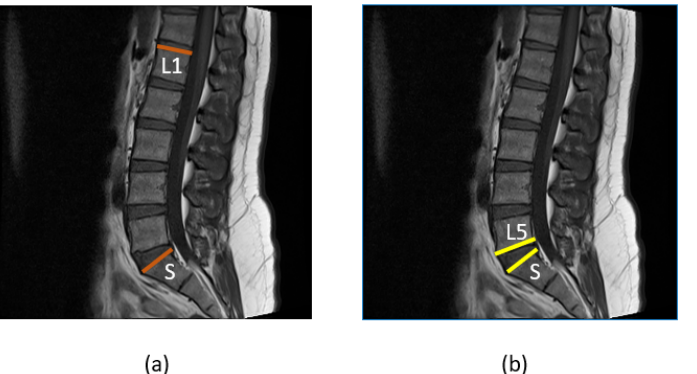
Figure 8. ( a ) Brown lines are drawn on the superior endplates of L1 and S to represent the lumbar lordotic angle ( b ) while yellow lines are drawn on the inferior and superior endplates of L5 and S to represent the lumbosacral